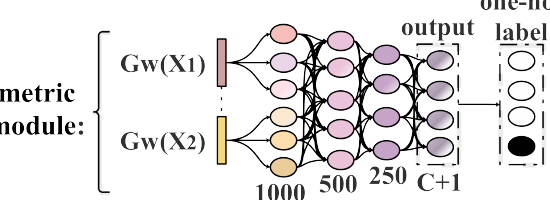
Figure 7. Architecture of our metric module, which is a fully connected network containing four fully connected layers. The input is the concatenation between a sample-pair’s features G W ( x w k ) . The output layer contains C + 1 neuron nodes, where C is the number of classes in G W ( x w k j